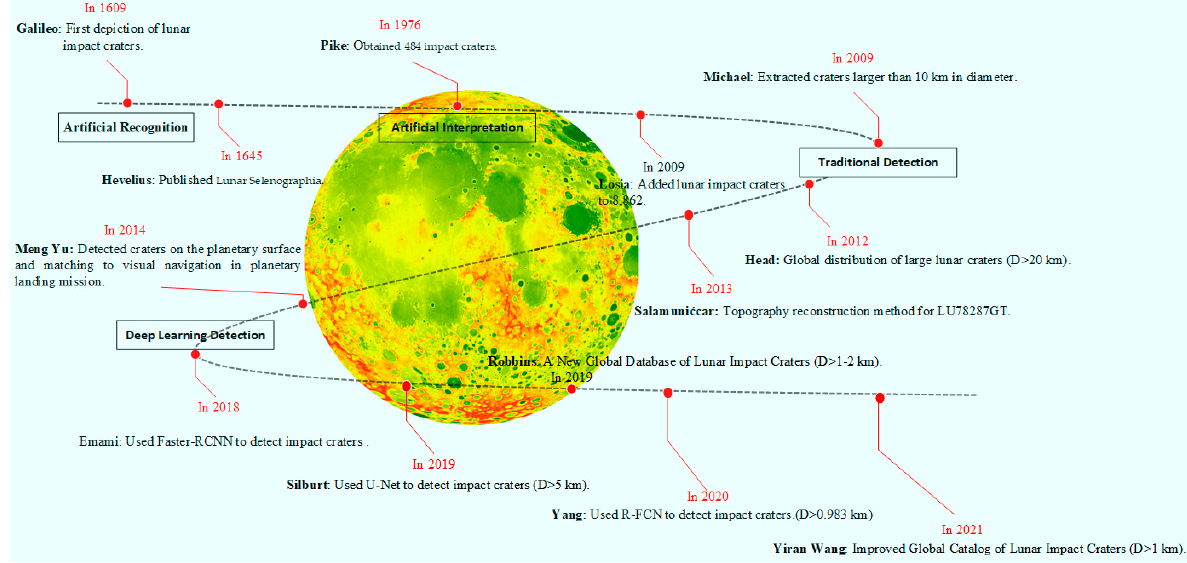
Figure 1. The development timeline of impact crater detection.